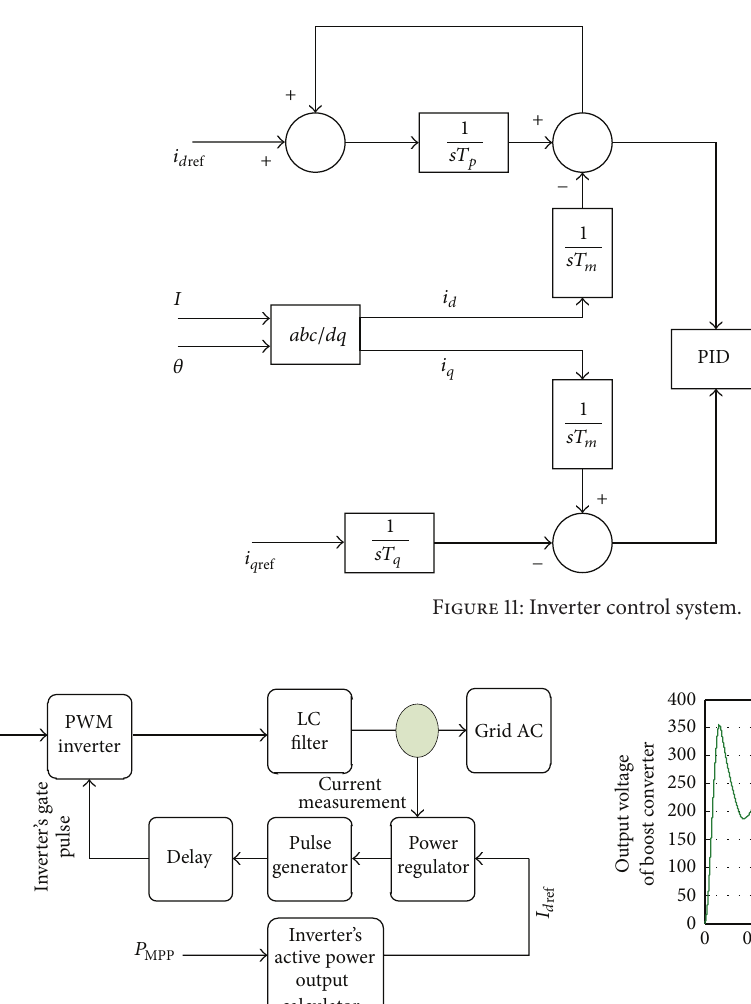
Figure 14: Output voltage of DC-DC converter without implement- ing filters.